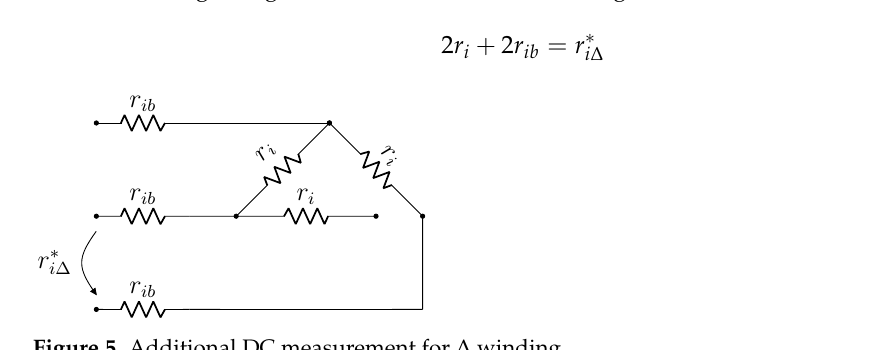
Figure 5. Additional DC measurement for ∆